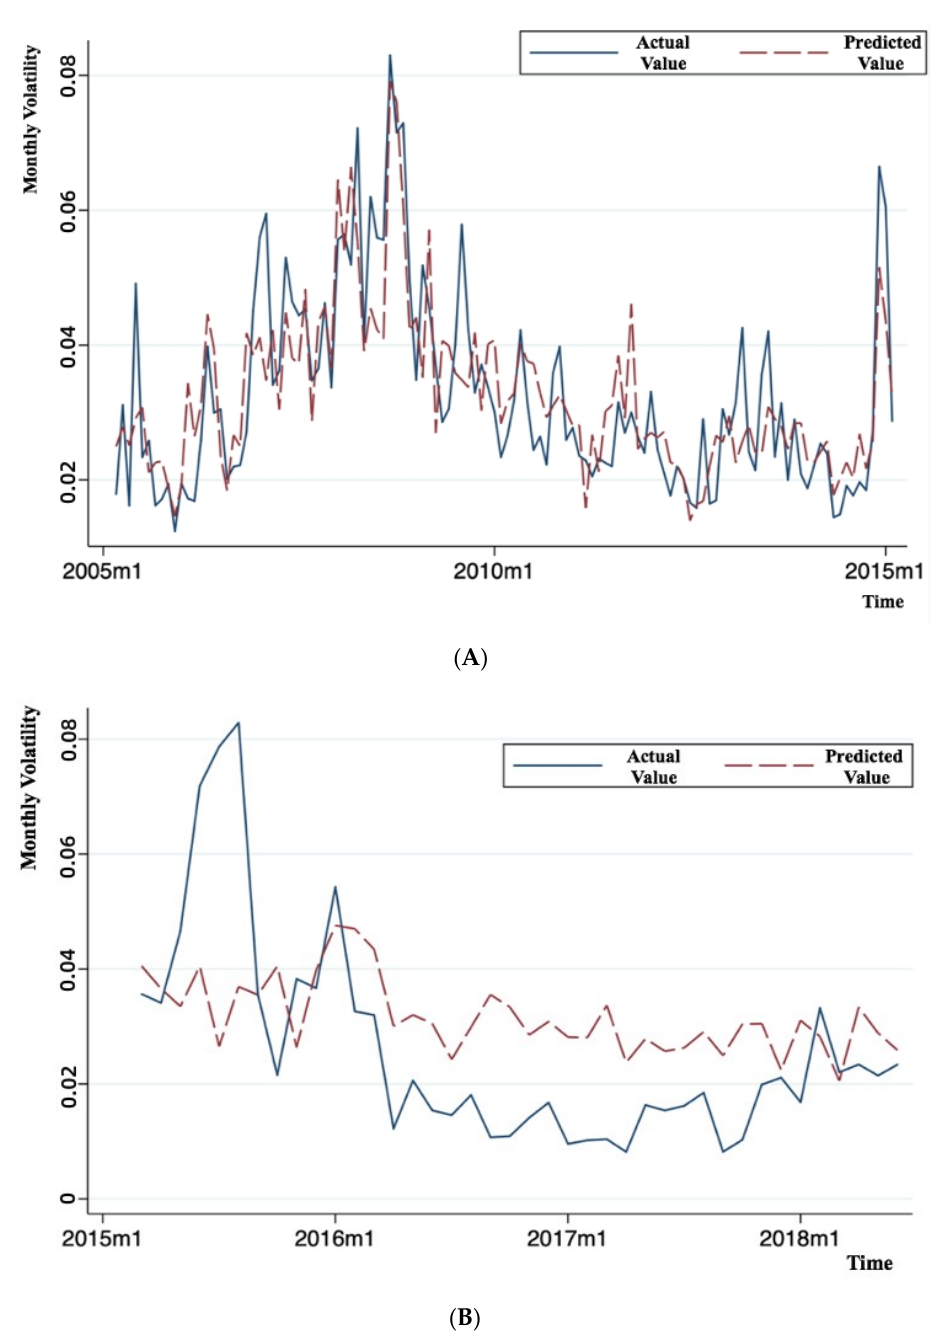
Figure 3. The predicted and actual monthly volatility: panel data evaluation approach. Panel ( A ) presents the predicted and actual monthly volatility of the SSE 50 index before introducing the index options and Panel ( B ) presents the predicted and actual monthly volatility of the SSE 50 index after introducing the index options.